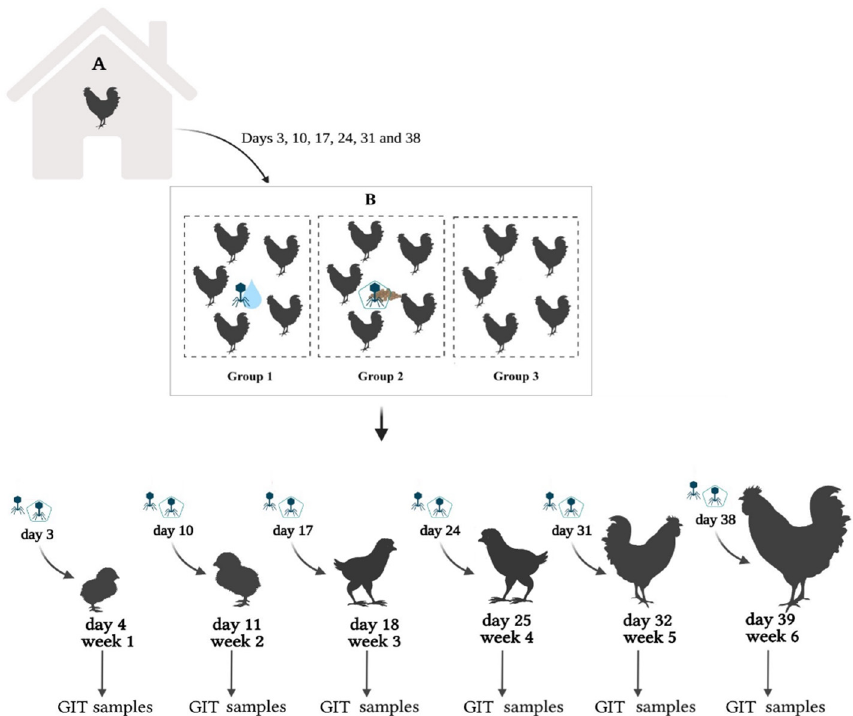
Figure 1. Experimental design of BP application and sampling throughout the entire production cycle. A: control poultry house; B: experimental poultry house; GIT: gastrointestinal tract. Group 1 received the FP via drinking water; group 2 received L100 via feed; group 3 was the control group. Created with BioRender.com.